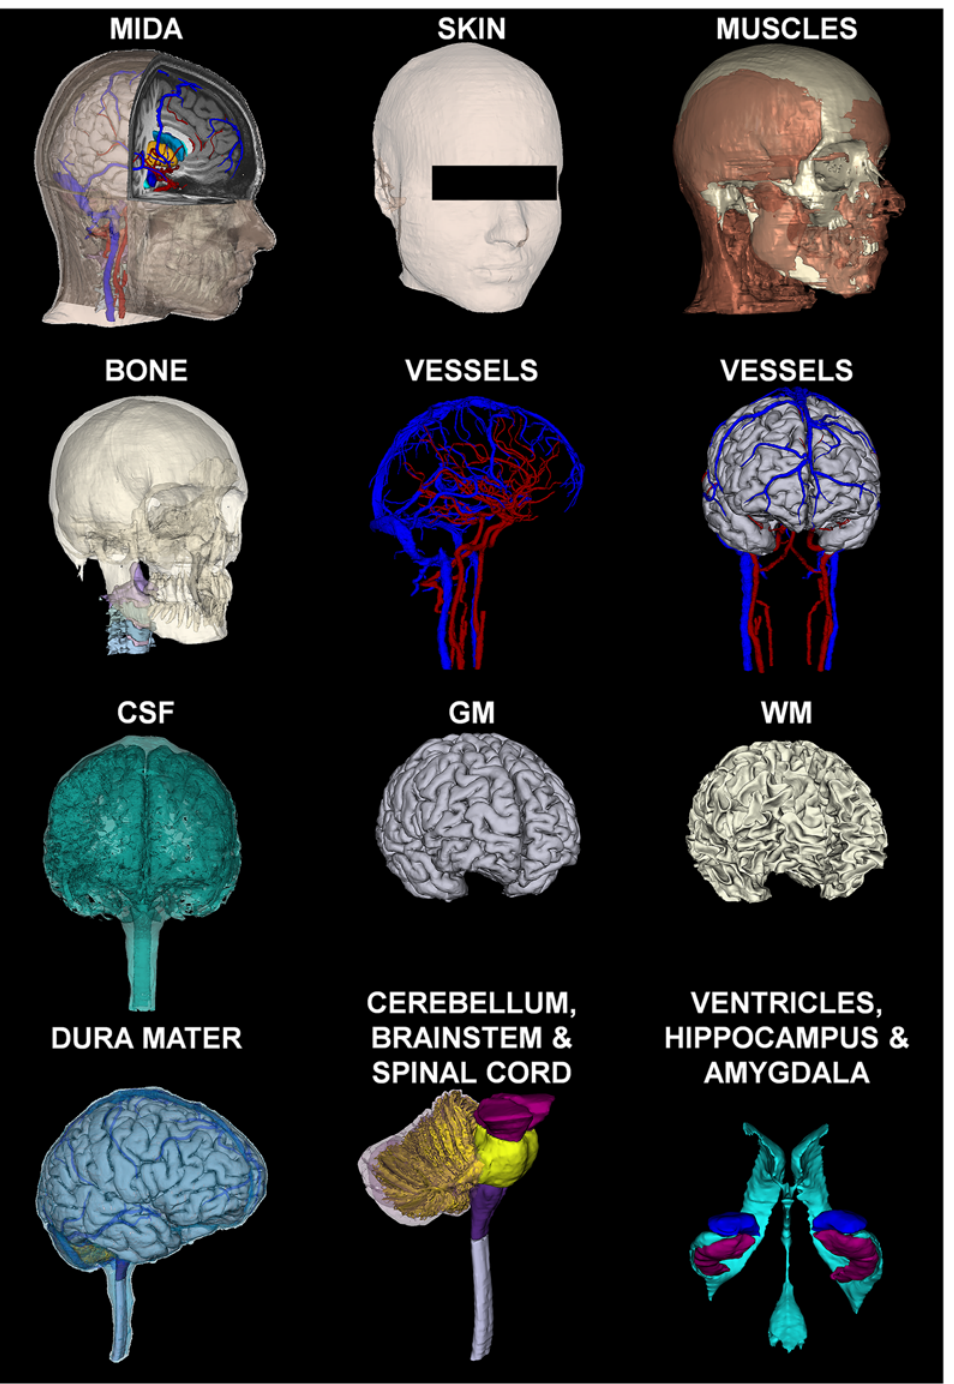
Fig 6. 3D Surfaces. 3D reconstruction of a few representative structures of the head and neck. The muscles are shown with the skull structures. The vessels are shown both without and with the GM. The dura mater is shown on top of the brain and vessels.